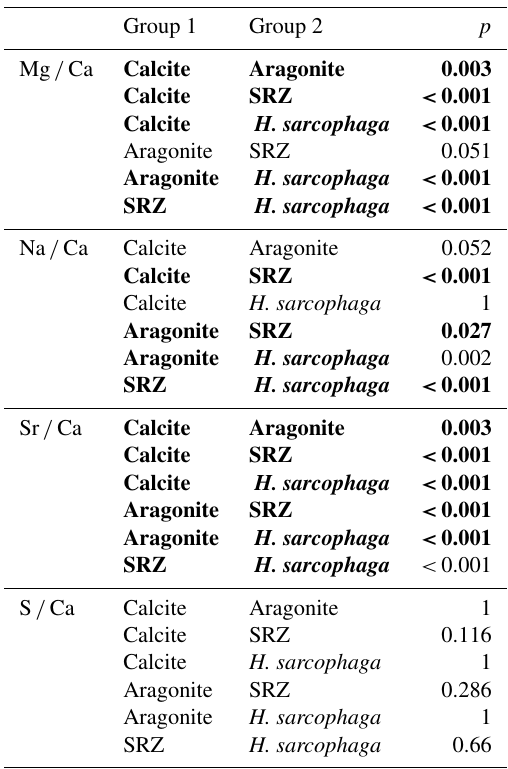
Table 1. Wilcoxon–Mann–Whitney test results of E / Ca compar- ison between the observed shell sections. Bold fields show signif- icant differences between the two groups. p values are Bonferroni